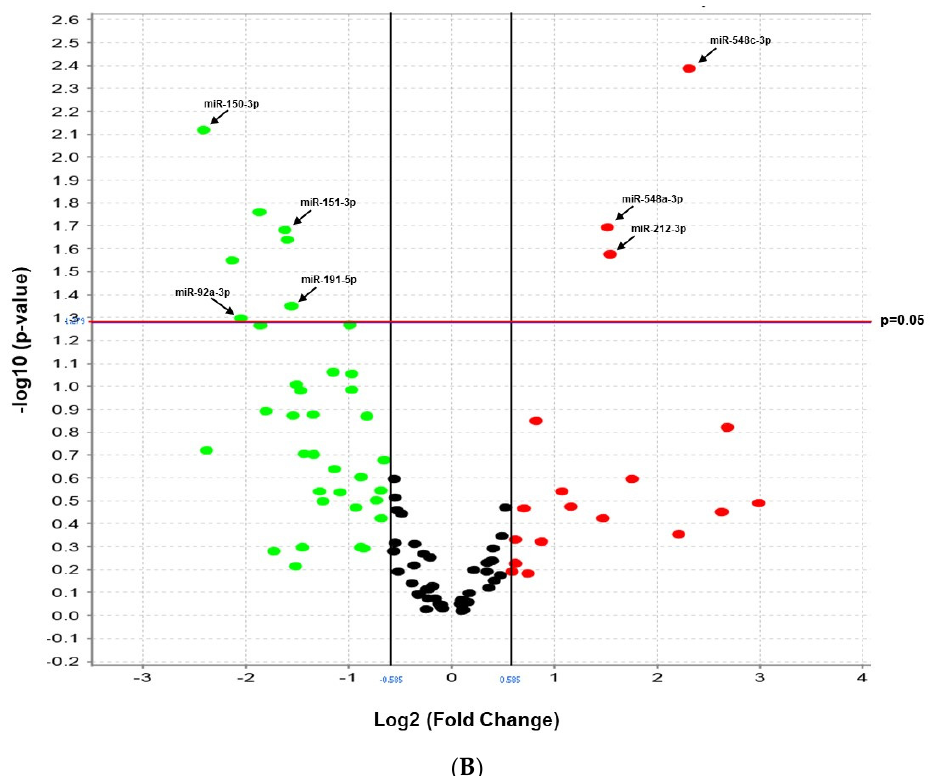
Figure 2. ( A ). Expression of microRNAs (miRNAs) in COVID-19 patients without radiological pulmonary improvement after hospital discharge, compared to patients with radiological pulmonary improvement (reference). Data are expressed as Fold change. Positive values mean upregulation and negative values mean downregulation. * p < 0.05 and # p < 0.01. ( B ). Differential expression analysis of microRNAs (miRNAs) obtained in the serum of COVID-19 patients without radiological pulmonary improvement after hospital discharge, compared to patients with radiological pulmonary improvement (reference). Volcano plot depicts the significantly altered miRNAs found ( p < 0.05). Each dot represents an miRNA: upregulated are in red (log2 fold change ≥ 1.5), downregulated in green (log2 fold ‐ change ≤ 1.5), and unchanged in black.